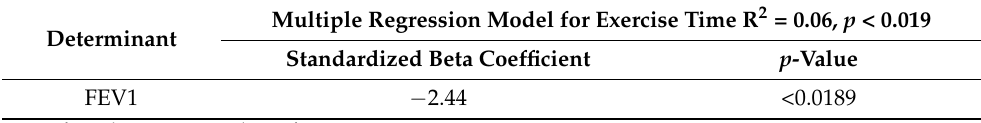
Table 4. Predictors of depressive and anxiety symptoms (HADS Total